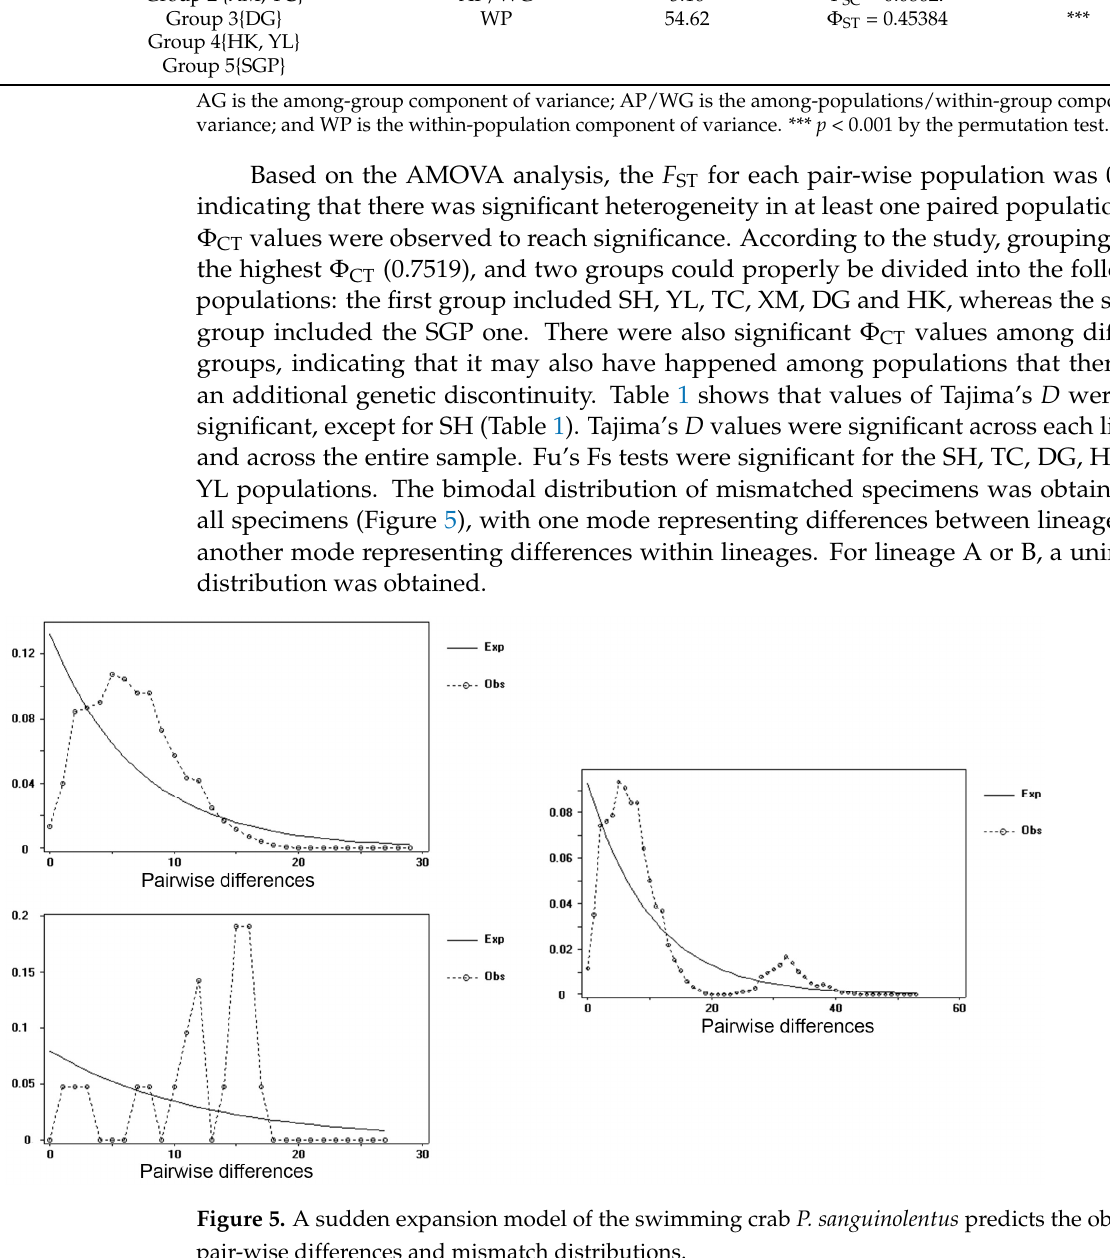
Population Grouping